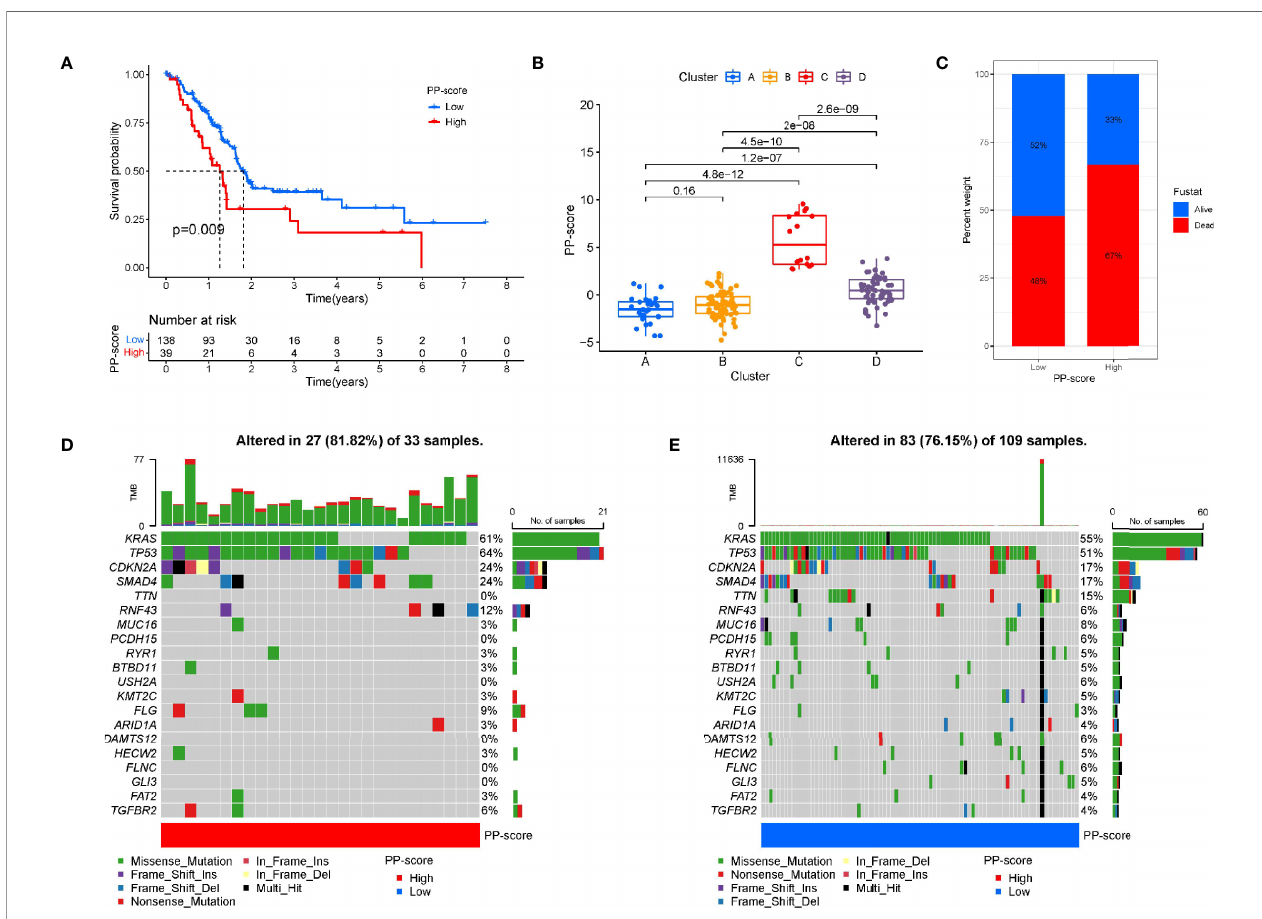
FIGURE 3 | Construction of pyroptosis score and correlation with tumour classi fi cation. (A) Kaplan-Meier survival curve between high and low PP-score group. (B) The correlation between tumour classi fi cation and PP-score. (C) The correlation between PP-score and survival state in PAAD patients. (D-E) The waterfall plot of tumor somatic mutation in high PP-score and low PP-score